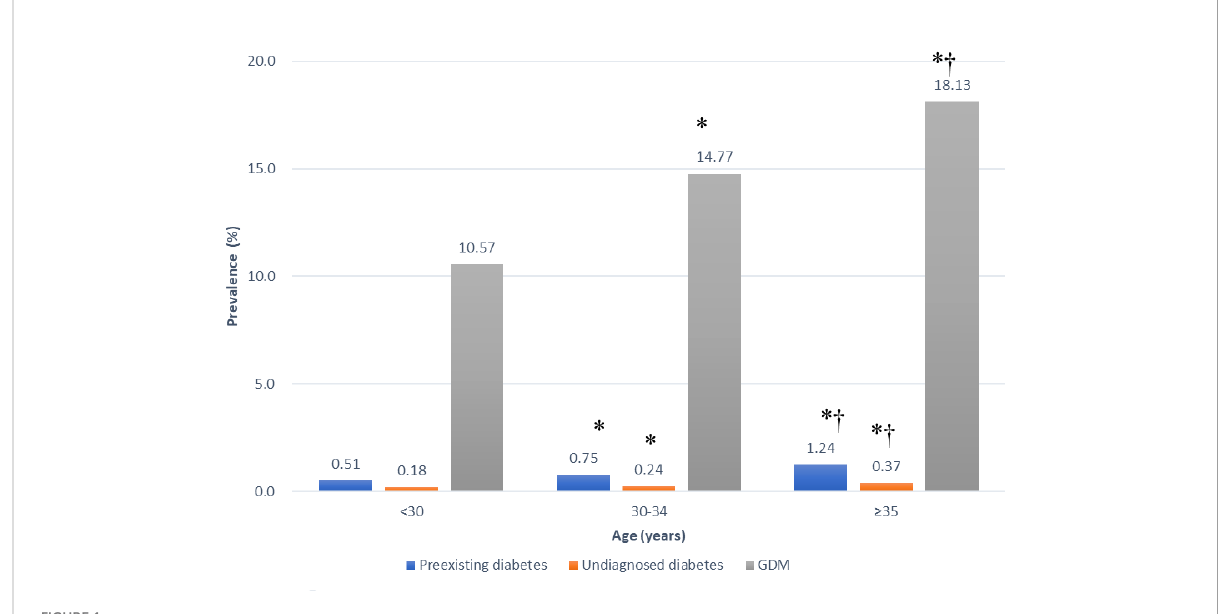
FIGURE 1 Prevalence of preexisting diabetes mellitus, undiagnosed diabetes mellitus and gestational diabetes mellitus (GDM) in different age groups in Taiwan in 2008-2017. *p < 0.05 vs. women aged <30 years. † p < 0.05 vs. women aged 30-35